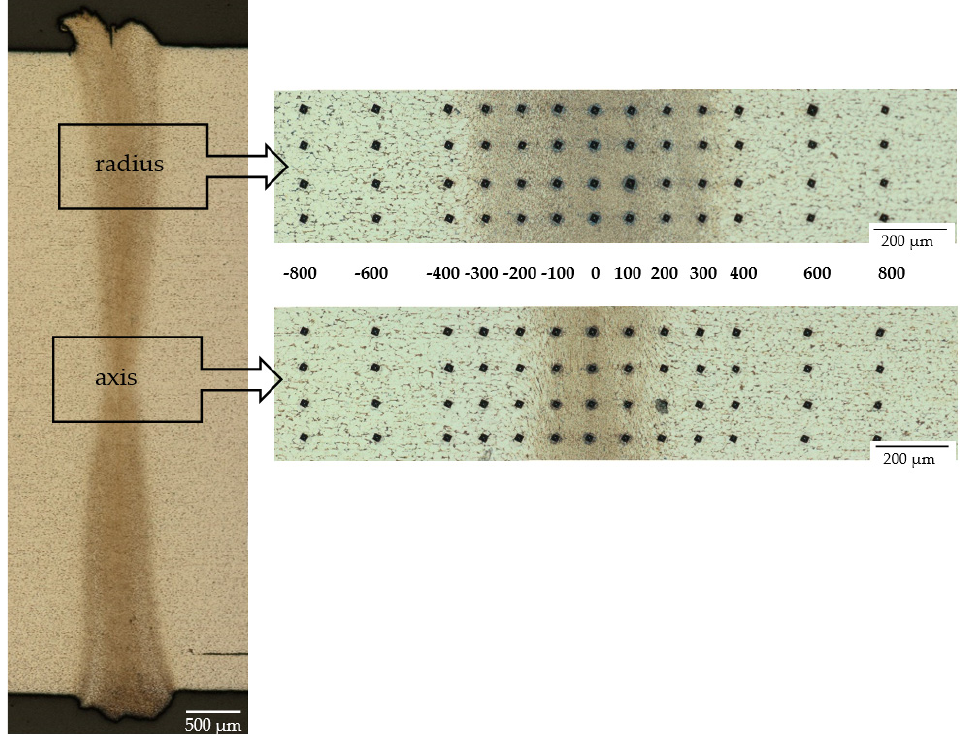
Figure 8. An example of the distribution of measuring points.